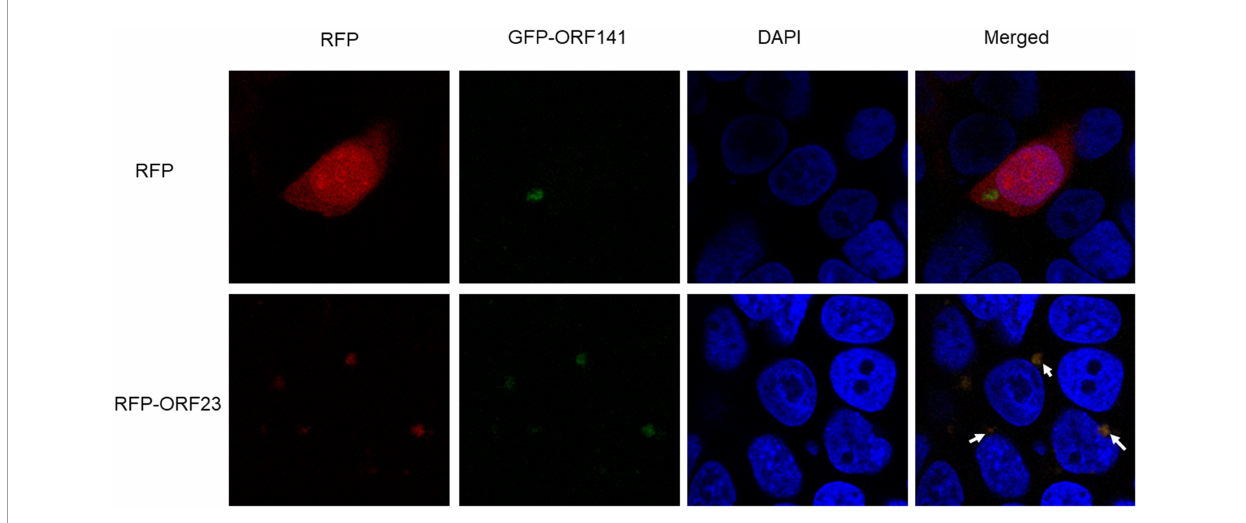
FIGURE4 Subcellular localization of ORF23 and ORF141. The control group HEK293T cells was transfected with pDsRed-N1 and pEGFP-N1-ORF141. The experimental group HEK293T cells was transfected with pDsRed-ORF23 and pEGFP-ORF141. Arrows indicate colocalization.